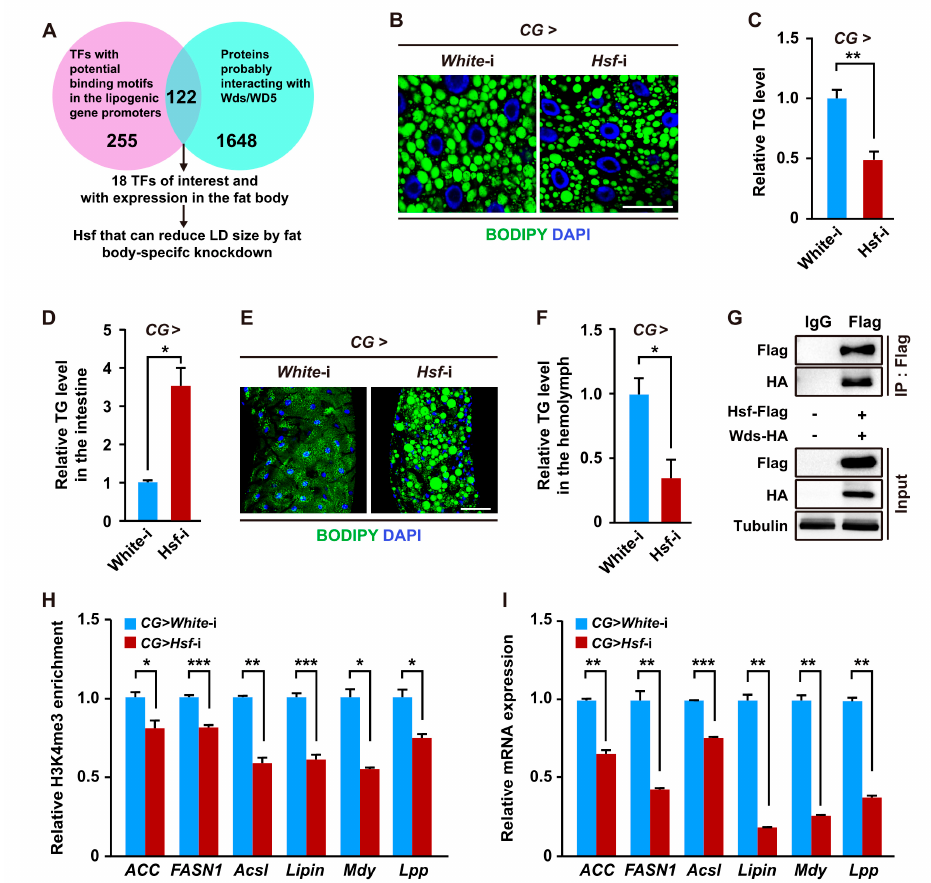
Figure 4. Hsf promoted lipid synthesis and transport by interacting with Wds to modulate H3K4me3 modification. ( A ) Schematic diagram for multiple approaches-based identification of the transcription factor Hsf that might interact with Wds, had potential binding motifs within the promoters of lipid homeostasis-related genes, and was involved in Drosophila lipid synthesis. ( B , C ) TRiP RNAi line (THU2458)-mediated Hsf knockdown in the Drosophila fat body reduced LD size ( B ) and decreased the TG levels (n = 3, 10 larvae per group) ( C ) of Drosophila third instar larvae. BODIPY, green; DAPI, blue. Scale bar, 50 µ m. ( D – F ) Fat body-specific Hsf knockdown caused elevated TG levels (n = 3, 20 larvae per group) ( D ) and lipid accumulation ( E ) in the intestine but decreased TG levels (n = 3, 60 larvae per group) in the hemolymph ( F ). BODIPY, green; DAPI, blue. Scale bar, 100 µ m ( E ). ( G ) Co-IP confirmation of the interaction between Flag-tagged Hsf and HA-tagged Wds that were transiently expressed in Drosophila S2 cells. The antibodies against the HA tag or Flag tag were used. Tubulin was used as the loading control. ( H , I ) Fat body-specific Hsf knockdown reduced H3K4me3 enrichment within promoters of lipogenic genes and Lpp ( H ) as well as decreased the transcriptions of these lipid homeostasis-related genes ( I ) in the fat body. Data are presented as the mean ± SE (error bars). For the significance: * p < 0.05, ** p < 0.01, and *** p < 0.001 versus the